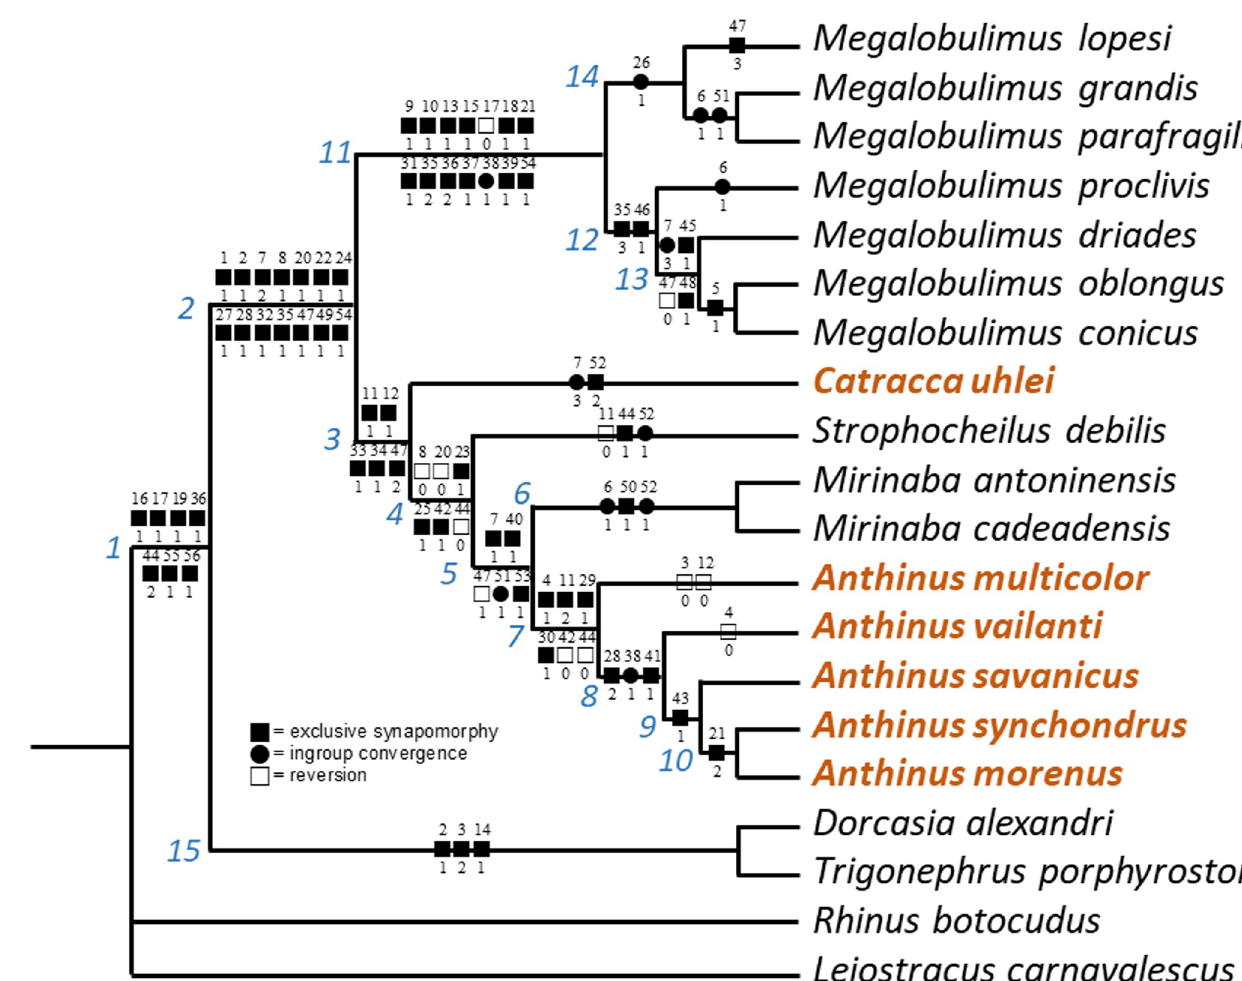
Fig 27. Single cladogram obtained analyzing the matrix (Appendix 2) of the species assembly reported in Material and Methods (written black), plus the species studied herein (written brown). Both branches below are far outgroups, a bulimulid ( Leiostracus ) and a simpulopsid ( Rhinus ). Branch 15 as close outgroups, two African dorcasiids. Each branch with synapomorphies shown. Each symbol as in the box; above number the character, below number the state. Branch numbers for discussion in blue italics. Method: parsimony; L = 283; CI = 68; RI =